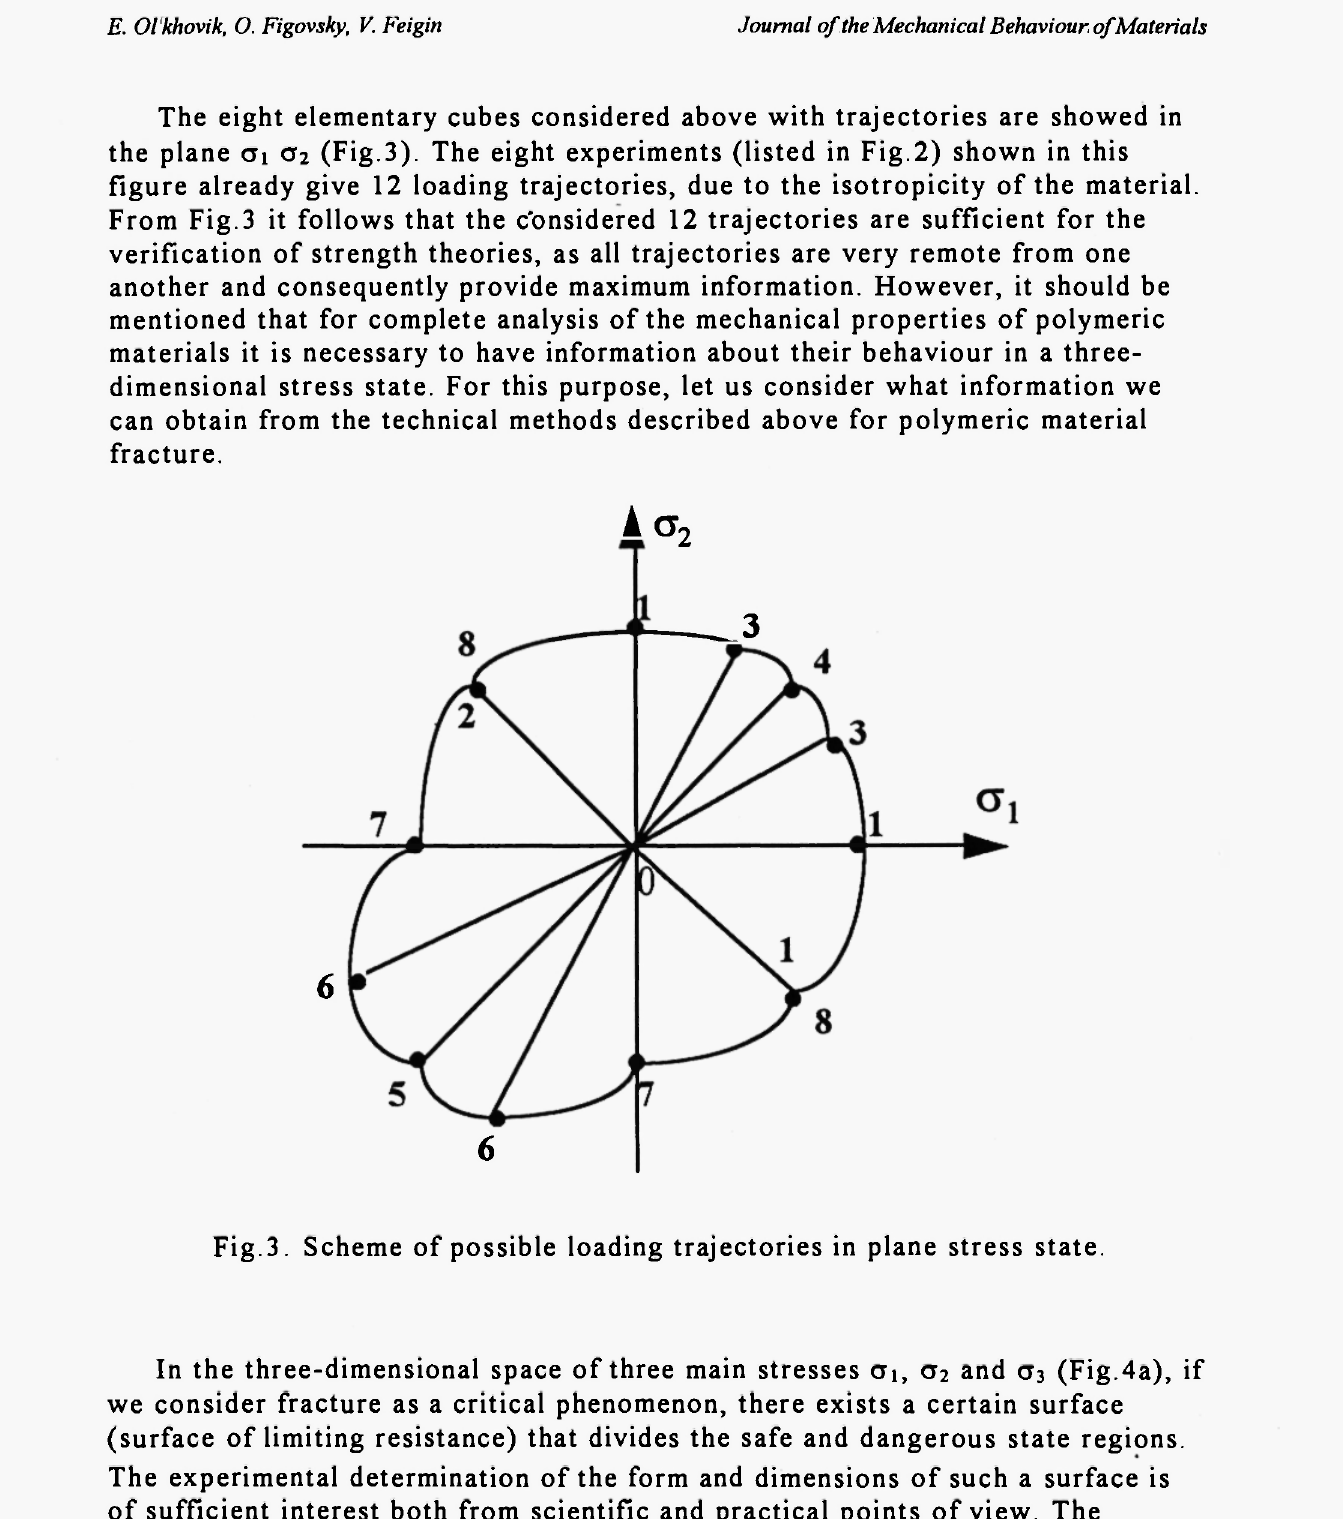
Fig.3. Scheme of possible loading trajectories in plane stress